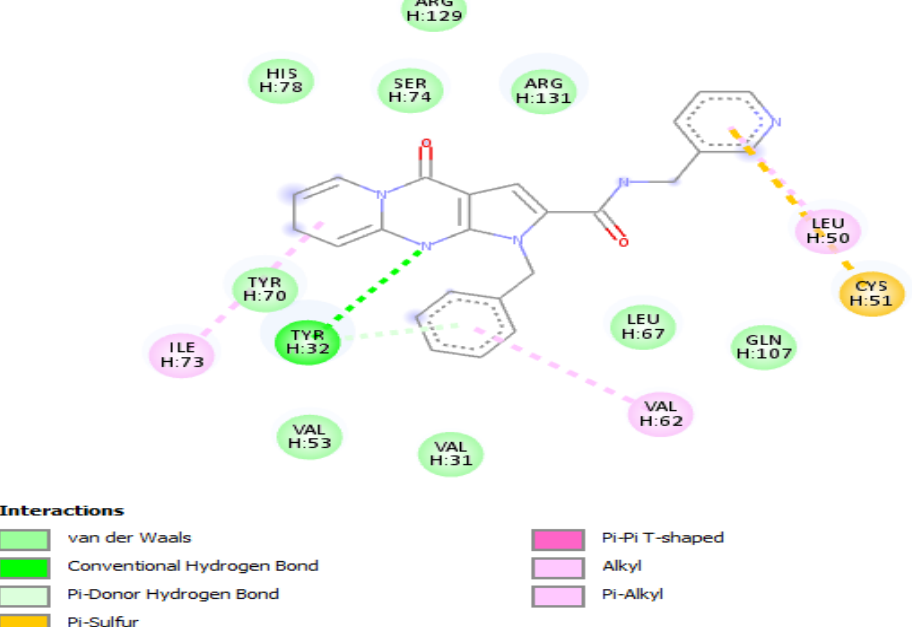
Figure 3. Positioning and interactions of the molecule F3345-0326 inside the active site of receptor HPV16E6 (PDB ID 4xr8). Molecular docking of the selected molecule F3374-0275 on HR E6 oncoprotein is re-